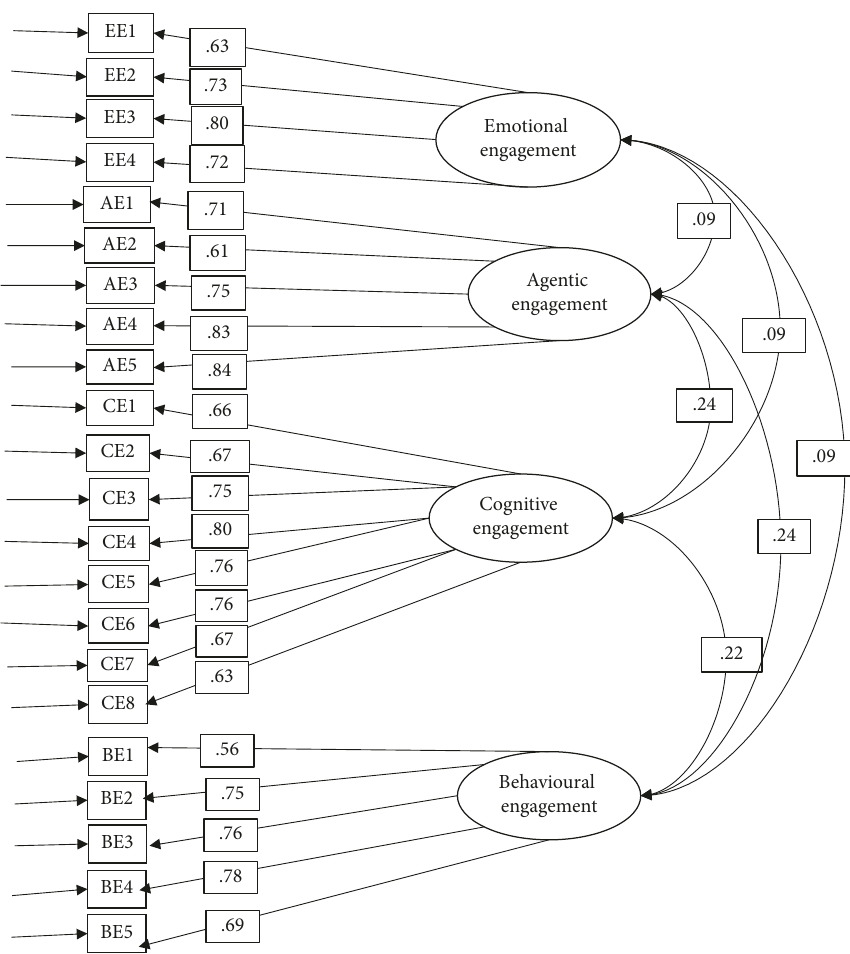
Figure 3: CFA of student engagement. Note: AE � agentic engagement; BE � behavioural engagement; EE � emotional engagement; CE � cognitive engagement. Table 4: Assessment of the measurement model.